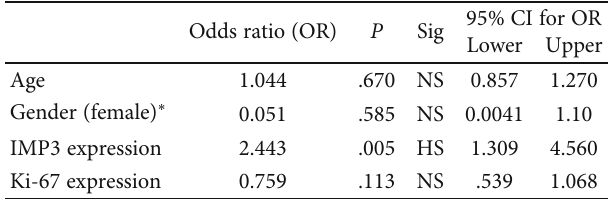
Table 4: Logistic regression to study independent factors associated with SCC.